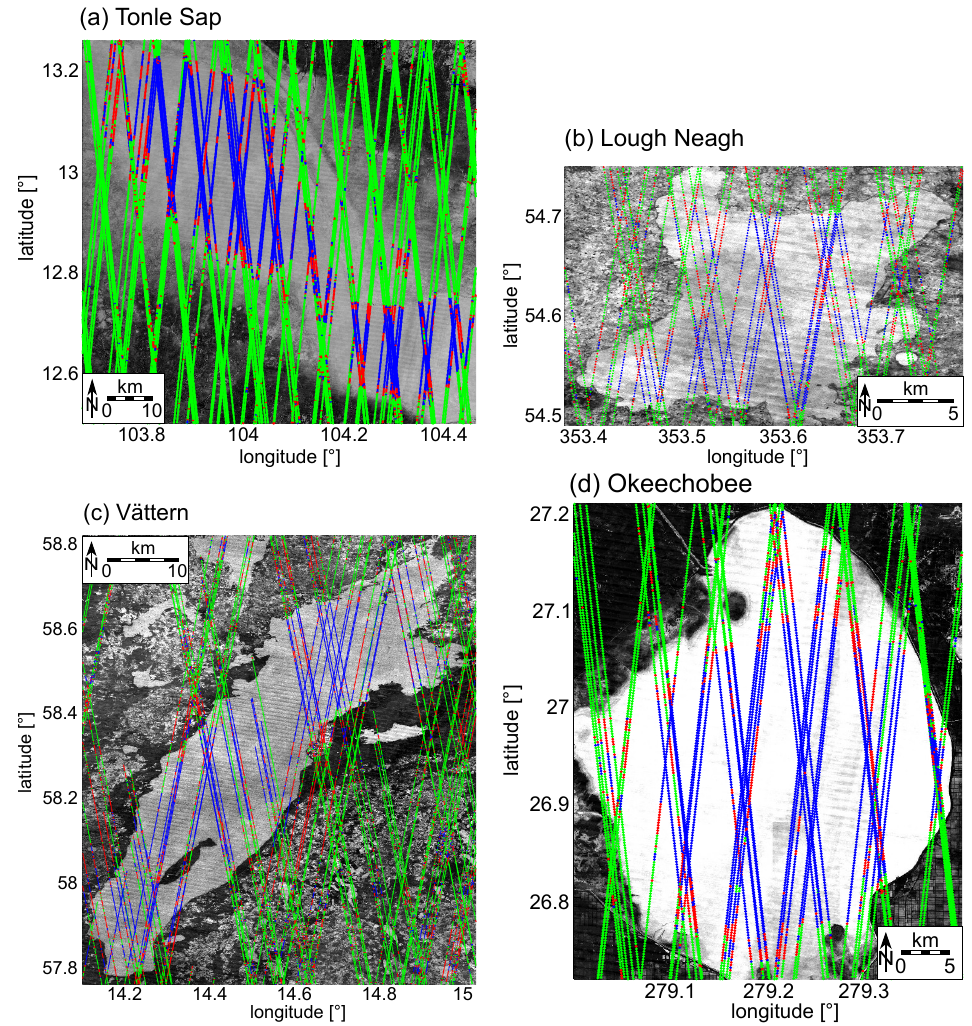
Figure 4. Classification result for tracks across the lakes ( a ) Tonle Sap; ( b ) Lough Neagh, ( c ) Vättern and ( d ) Okeechobee: water (blue), land-water transition (red) and land (green). The intensity of the gray values of the background image signify the probability of the existence of water (based on USGS Landsat 5, 7 and 8 images). The lighter the gray level the higher is the probability that the area is covered by